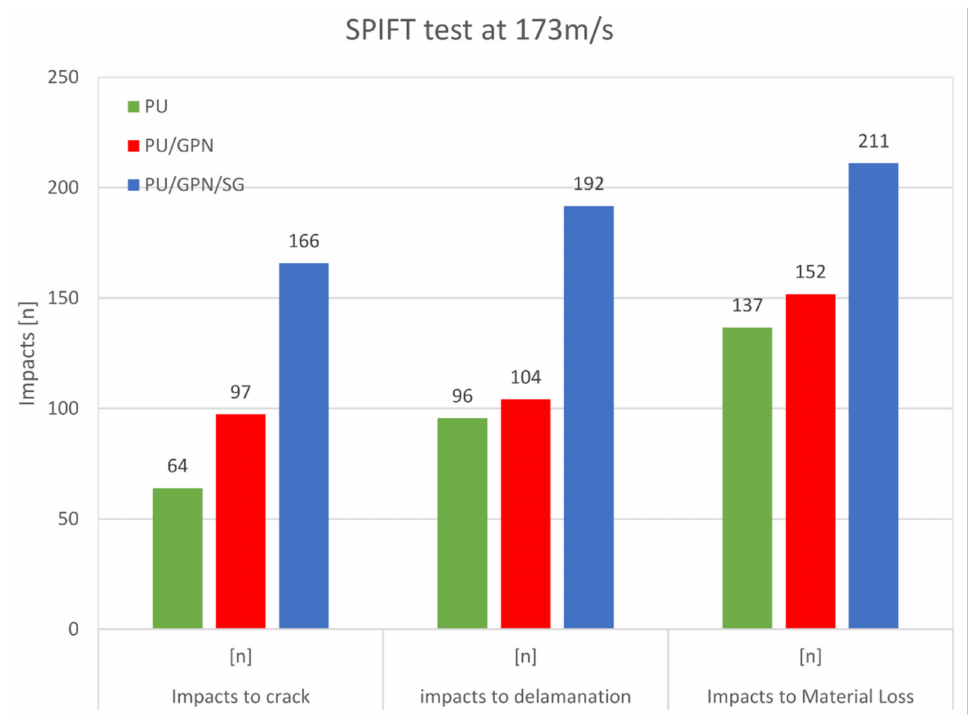
Figure 6. SPIFT tests results for PU, PU + GNP, and PU + GNP + SG at 173 m/s, each color represents a single